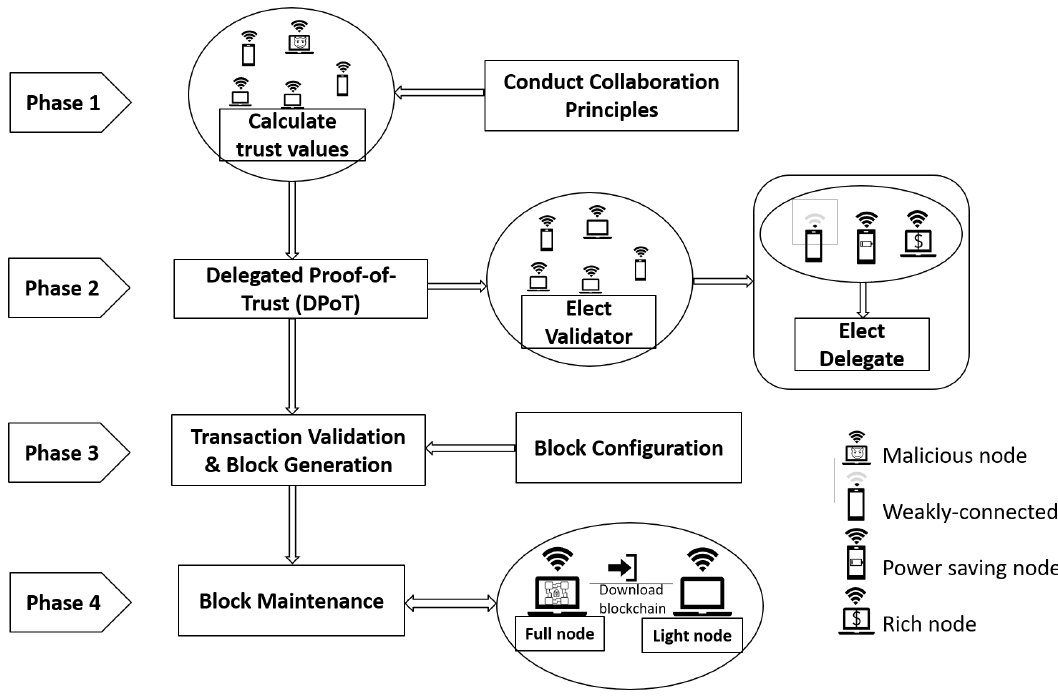
Figure 5. System Design for a Lightweight Trust